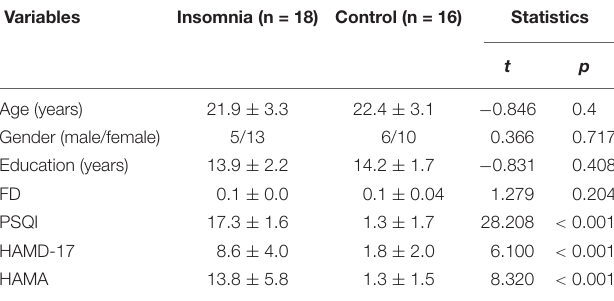
TABLE 1 | Sample characteristics.